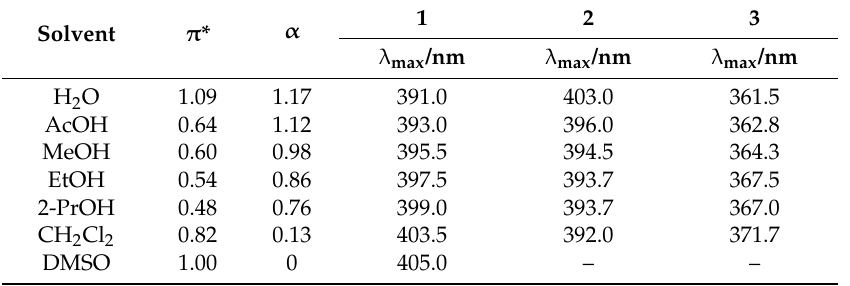
Table 4. Solvent parameters and absorption maxima of the triazenes 1 – 3 in polar solvents.